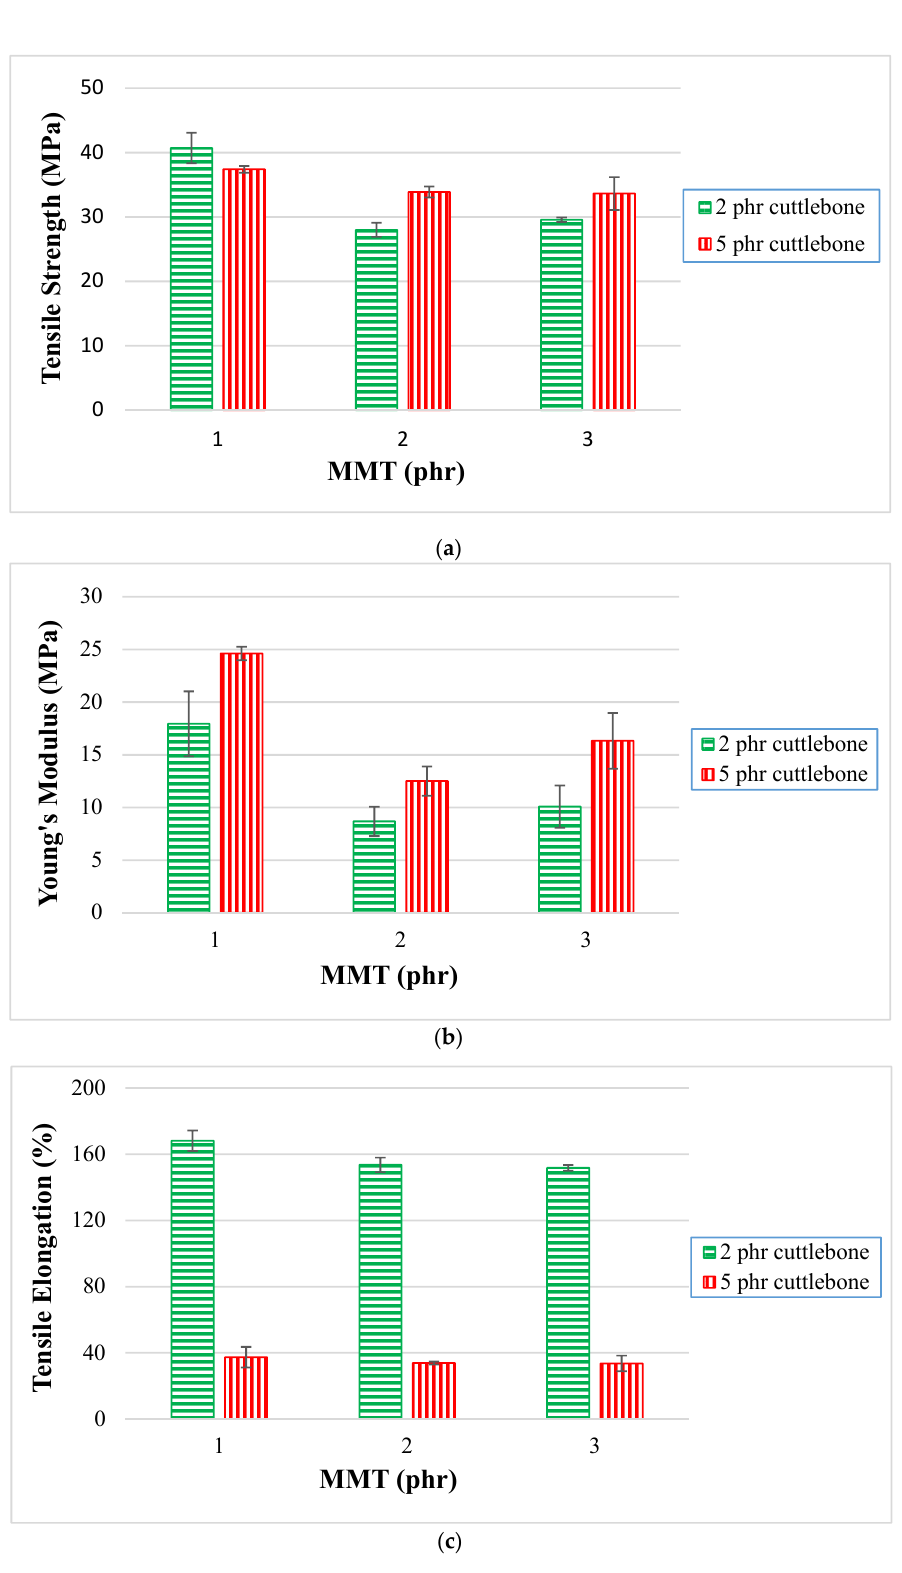
Figure 1. ( a ) Tensile strength, ( b ) Young’s modulus, and ( c ) tensile elongation (%) for PVOH-calcined cuttlebone-MMT nanocomposites.